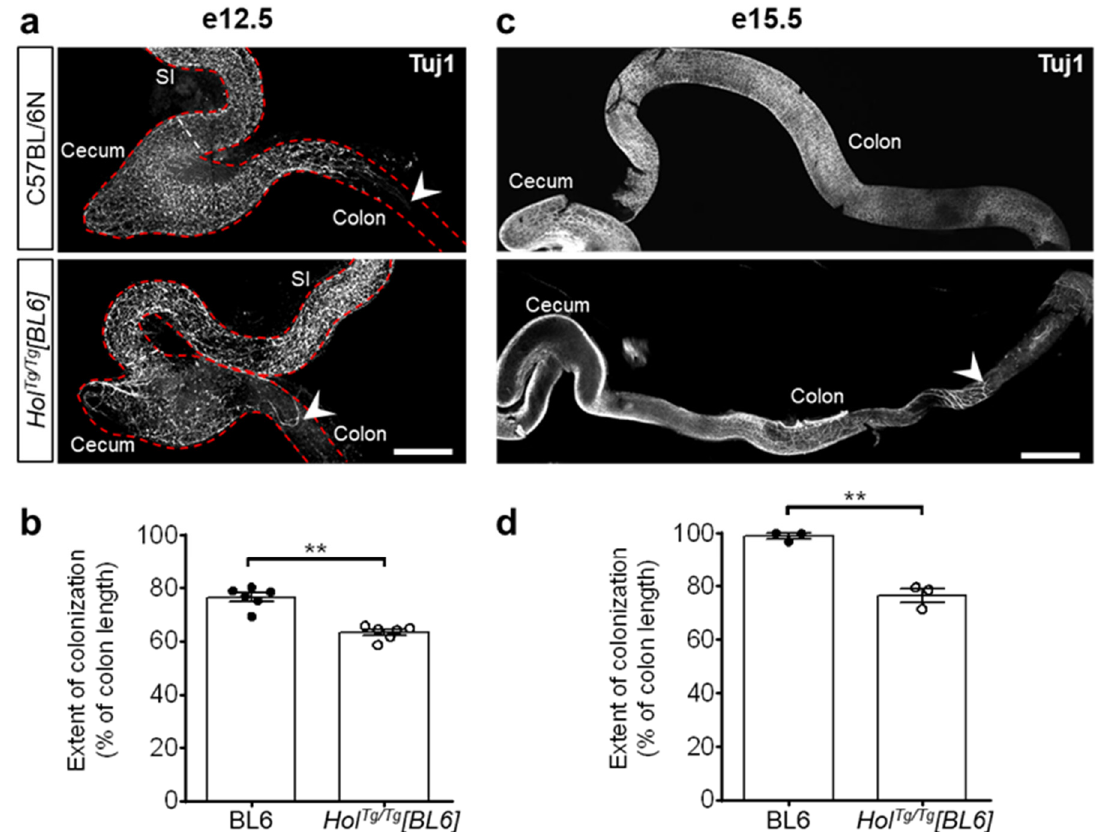
Figure 3. Colonization by ENS progenitors has delayed in the colon of Hol Tg/Tg [BL6] embryos. ( a , c ) Immunofluorescence staining of β III-Tubulin (Tuj1) in whole-mount preparations of embryonic guts at e12.5 ( a ) and e15.5 ( c ), with migratory front indicated by arrowheads. Scale bar, 400 µm ( a ) and 700 µm ( c ). ( b , d ) Quantification of extent of colonization by ENS progenitors (expressed in % of total colon length) at e12.5 ( b ) and e15.5 ( d ), using images such as those displayed in panels a and c. ** p < 0.01, two-tailed Student’s t -test.